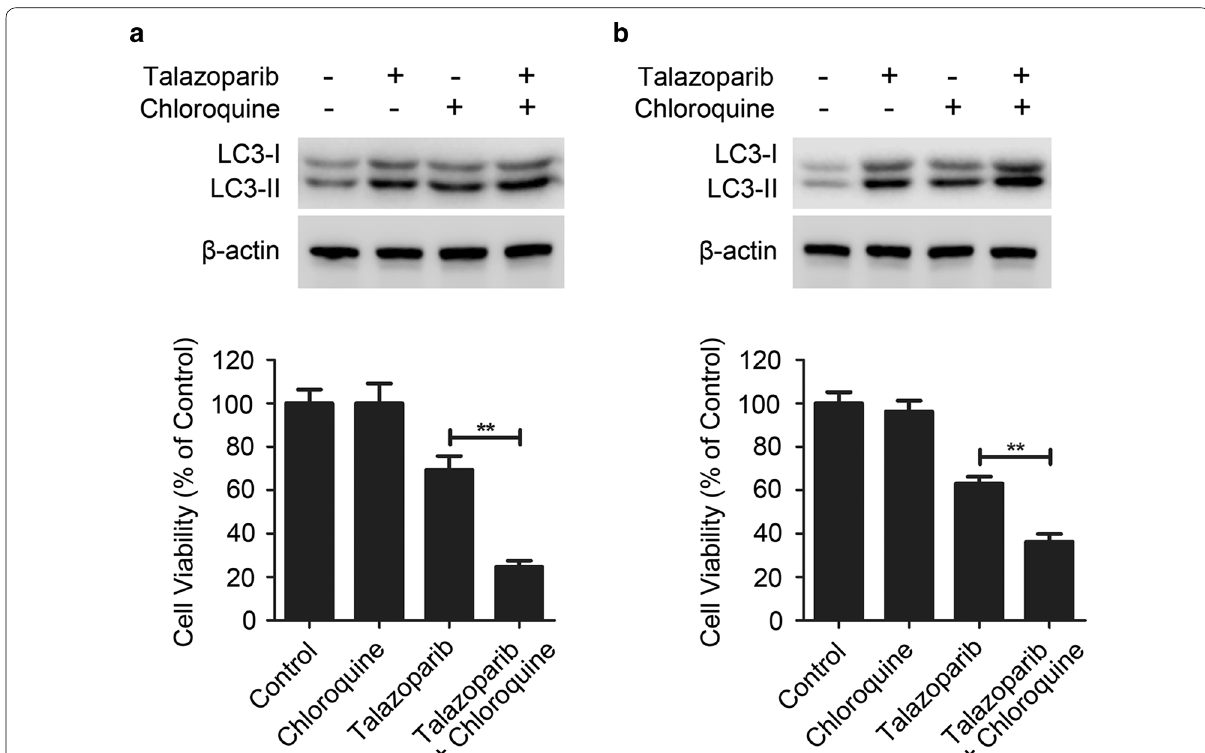
Fig. 5 Autophagy inhibition potentiated the cytotoxicity of talazoparib in CML cells. CML P#1 cells ( a ) and P#2 ( b ) were treated with 20 μM of talazoparib in with/without of 20 μM of chloroquine. The expression of LC3-I/II was detected by immunoblot analysis. Cell viability was measured